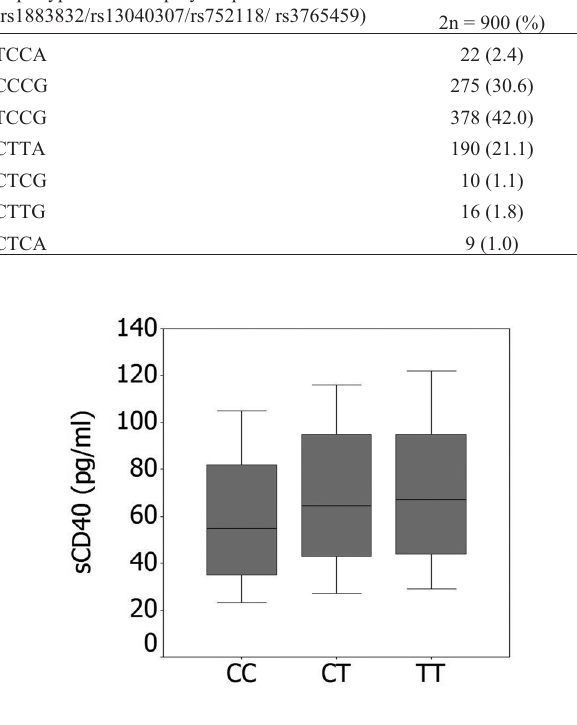
Table 4 - Haplotype analysis of the four polymorphism between ischemic stroke (IS) patients and control subjects. Haplotypes of CD40 polymorphisms (rs1883832/rs13040307/rs752118/